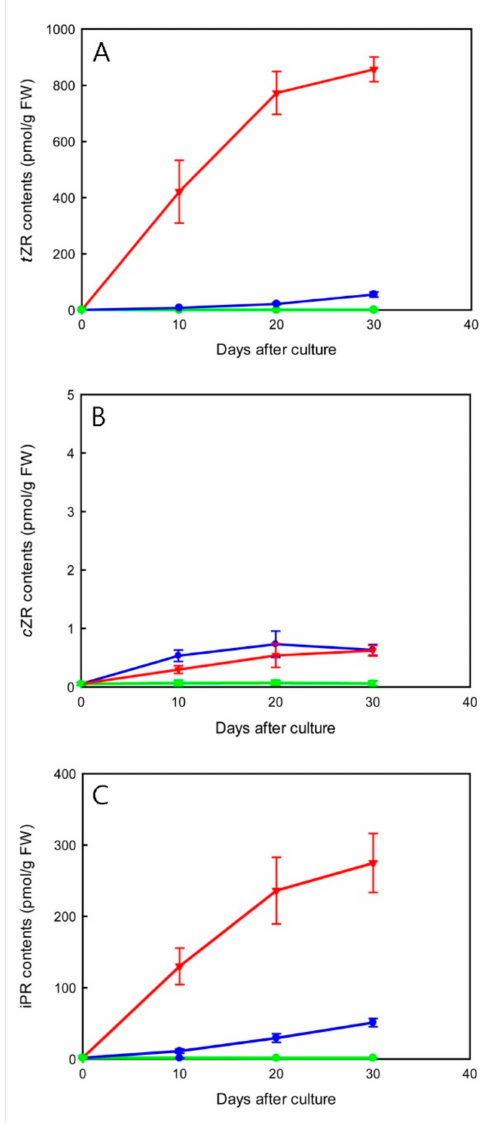
Figure 5. The effect of TDZ treatments on changes of total contents (pmol/g FW) of CK ribosides ( A ) t ZR, ( B ) c ZR, and ( C ) iPR in micropropagated shoots. Data are the mean of three biological replicates and error bars represent ± standard